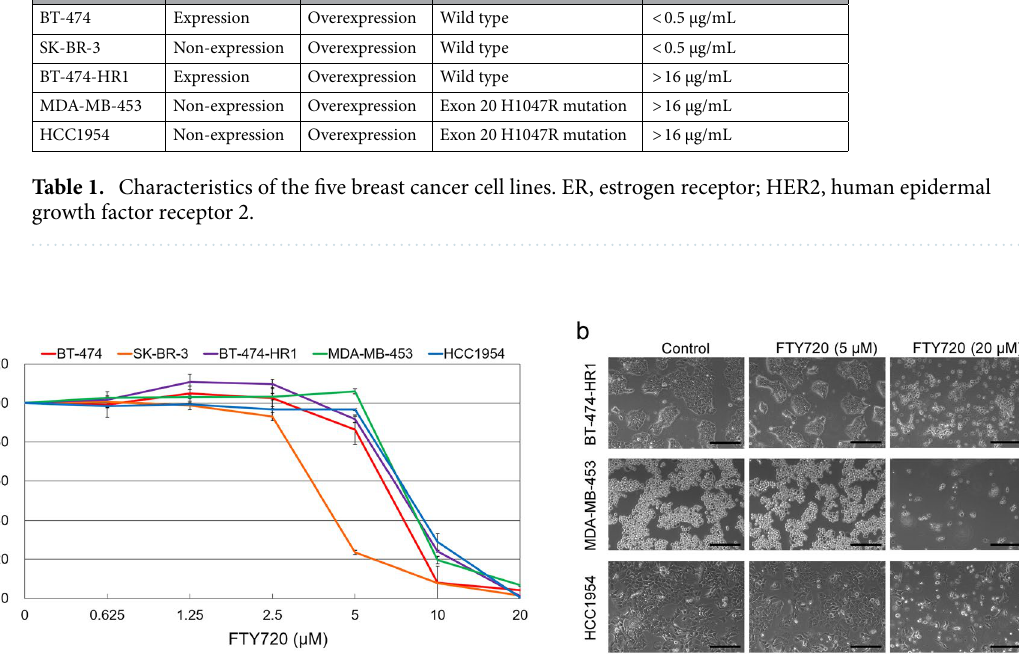
Figure 2. FTY720 hinders the growth of trastuzumab-resistant cells. ( a ) FTY720 inhibited cell growth in the five HER2-overexpressing cell lines. The percentage of WST-1 absorbance in cells was measured 72 h after the incubation with FTY720 (0.625–20 μM) with results being normalized to cells without treatment. Each plot indicates the mean value of at least three experiments, whereas error bars indicate the standard error of